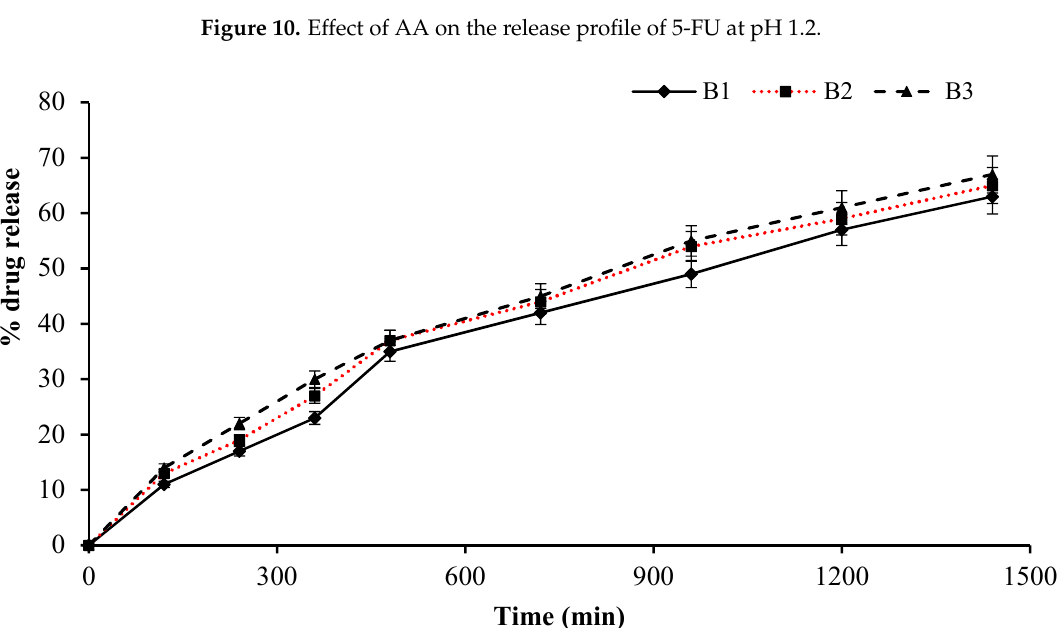
Figure 11. Effect of AA on the release profile of 5-FU at pH 7.4.